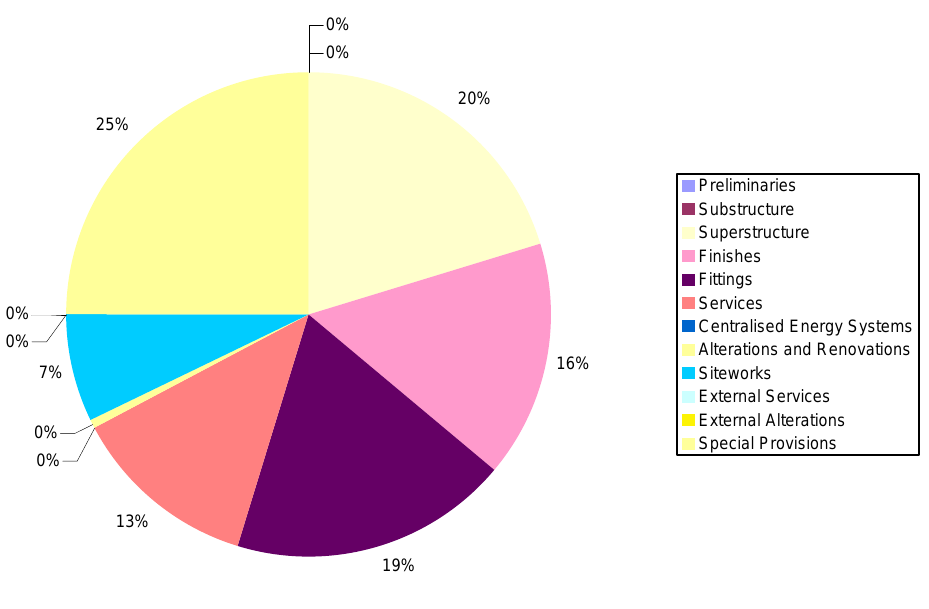
Figure 2: Recurrent Embodied Energy Distribution by Elemental Group The distribution of energy within the major elemental groups and how this changes